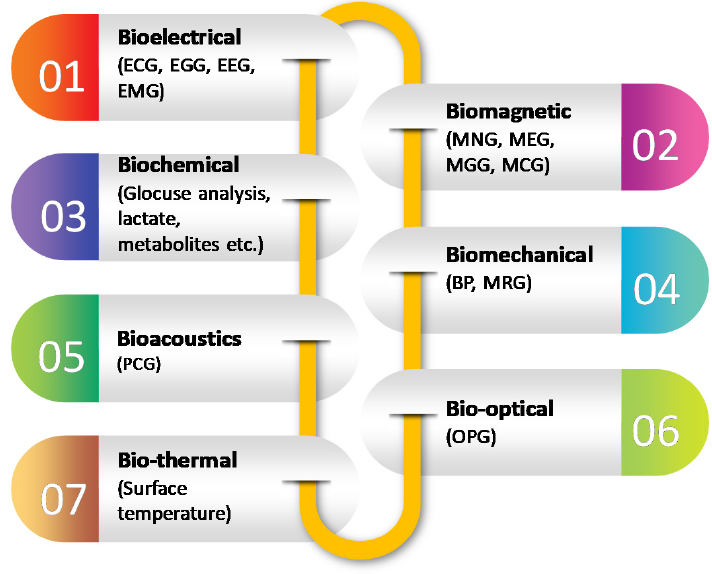
Figure 3. Types of biosignals in the human body (information taken from [8]).